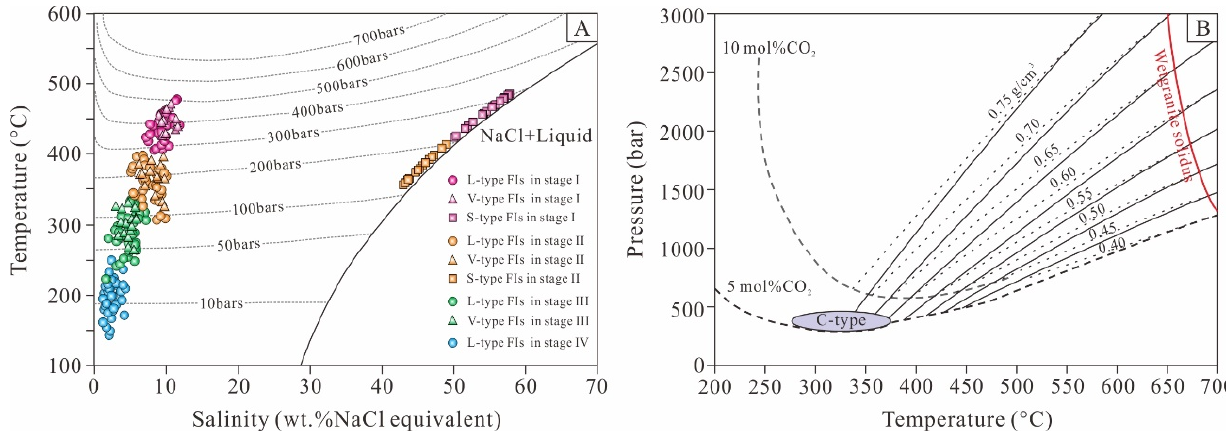
Figure 12. ( A ) Pressure estimation for FIs from the Huoluotai Cu (Mo) deposit. ( B ) Isochores for fluid of 4 wt.% NaCl, 5 mol% CO 2 (straight lines), and 10 mol% CO 2 (dashed lines). Data for the C-type FIs plot in the oval